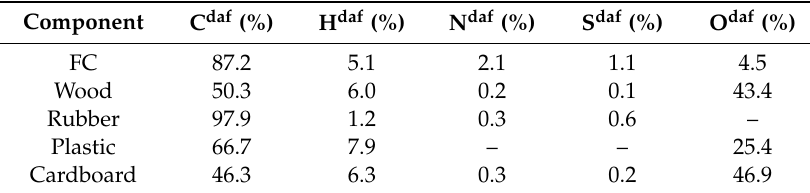
Table 4. Ultimate analysis of fuel components